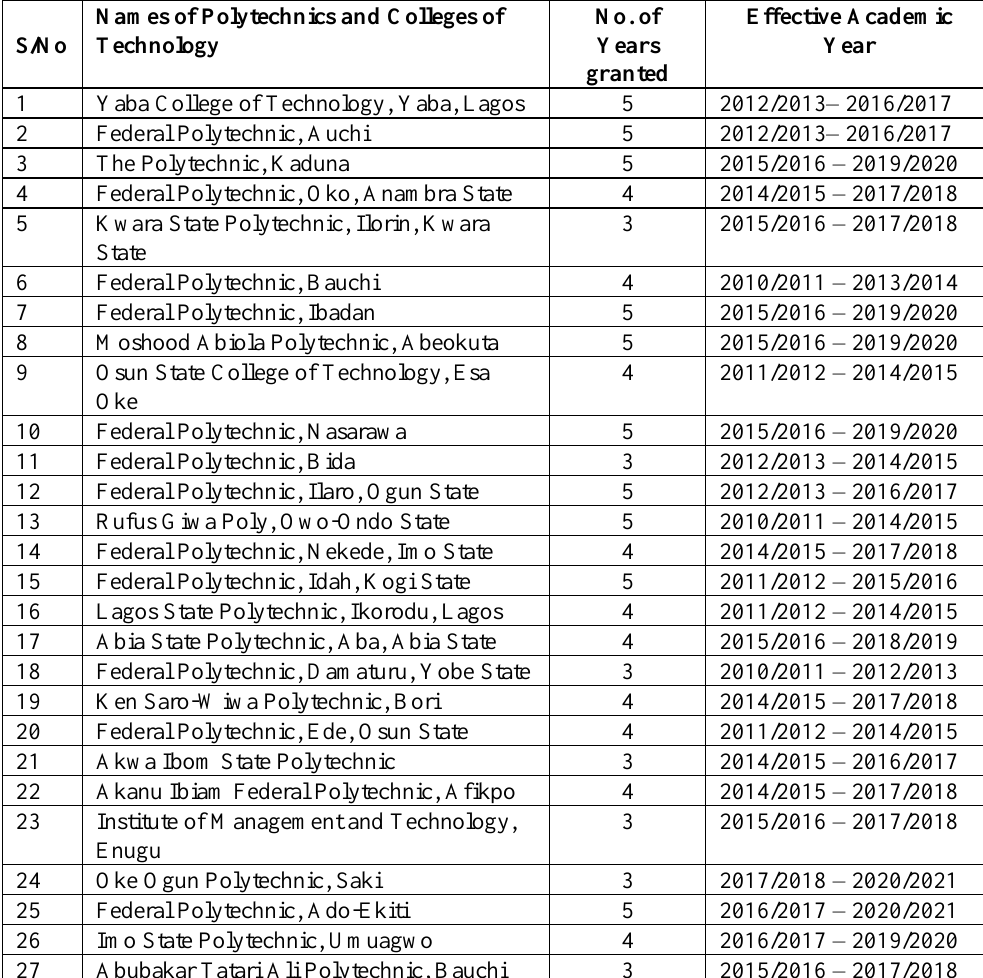
Table 5. Accredited Polytechnics and Colleges of Technology for Estate Management Courses (Estate Surveyors and Valuers Registration Board